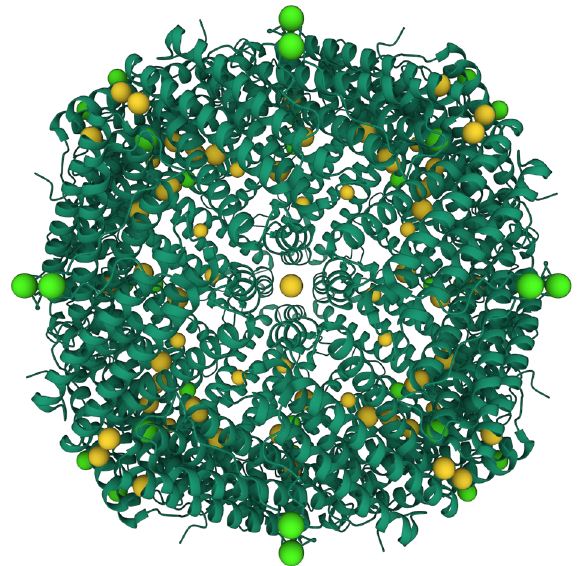
Figure 8. Re-engineered human ferritin for the synthesis of gold nanoparticles shows the presence of a significant amount of bound gold ions (PDB entry ID 3es3 [64]). Protein represented as a ribbon plot of half of the symmetrical sphere to visualize the protein shell interior. Gold and chloride ions are represented as golden and green-colored spheres, respectively.